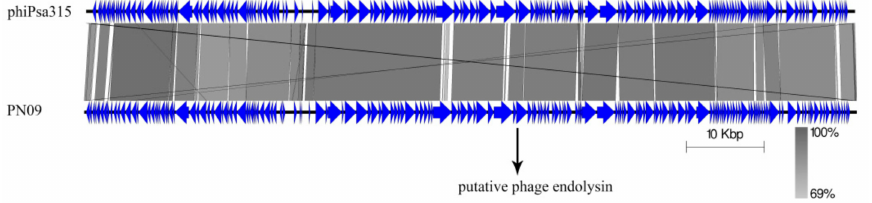
Figure 4. BLASTn comparison of the complete genome sequence of the phage PN09 with the closet homolog phage phiPsa315 using Easyfig. The blue arrows indicate the predicted genes of both phages. The homologous regions between the phages are indicated by gray shading.